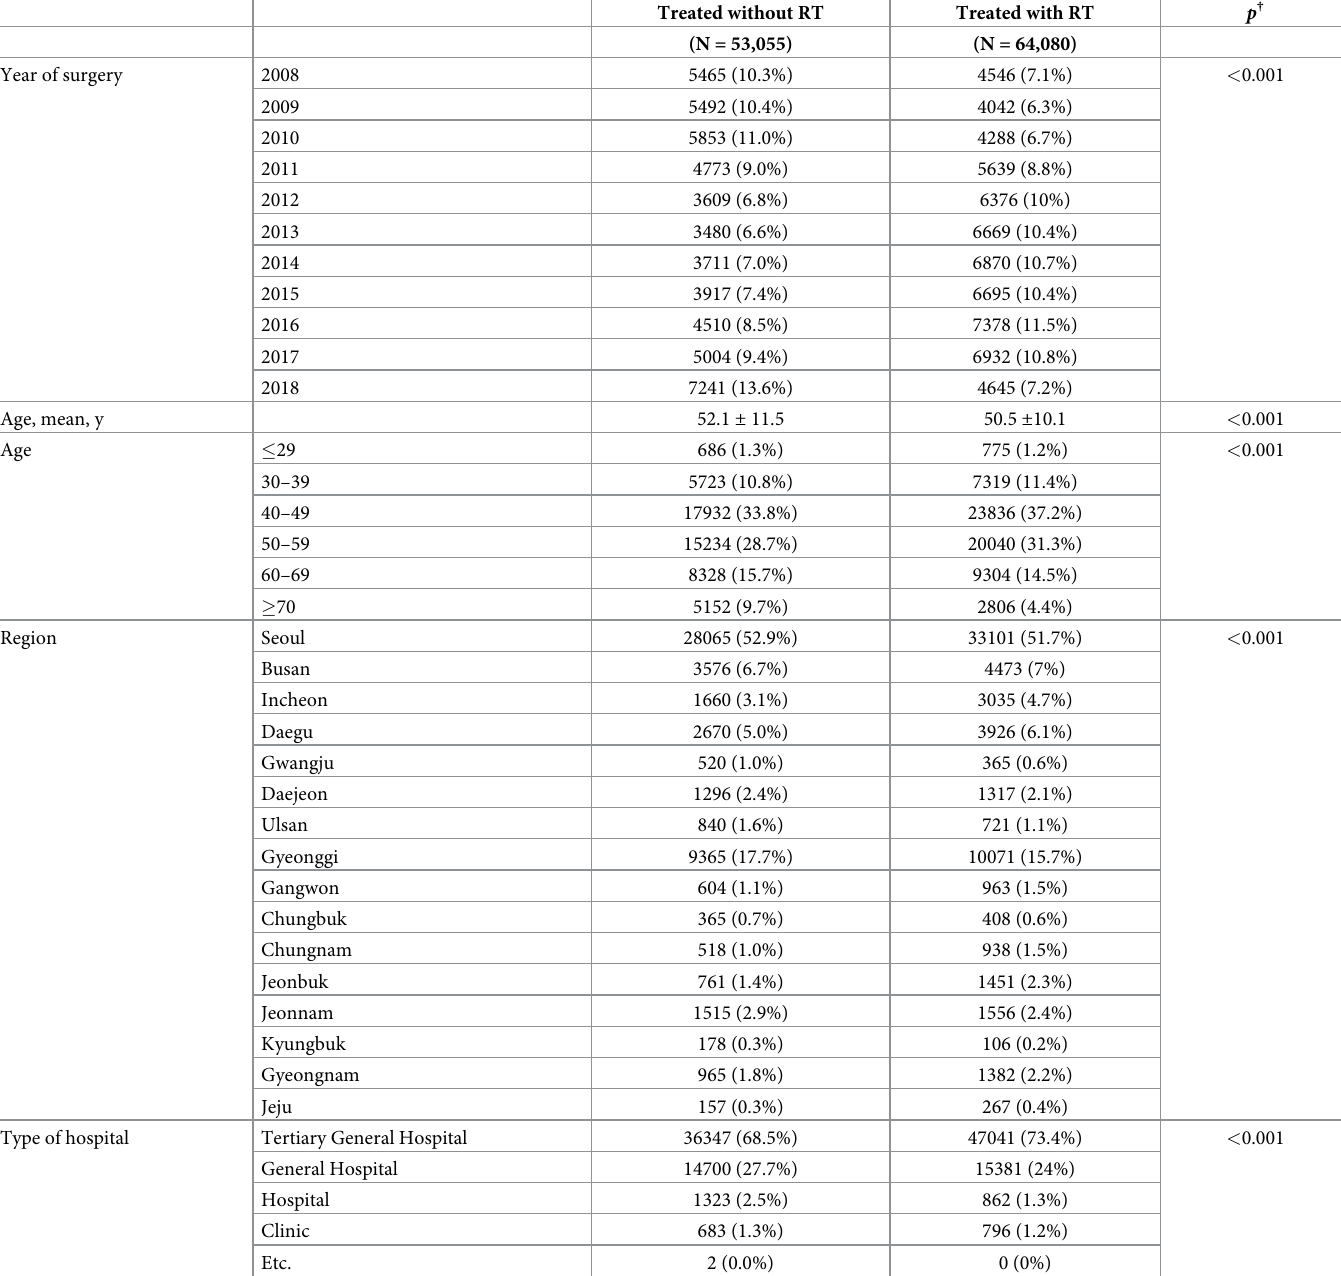
Table 1. Characteristics of all patients who received RT and those who did not receive